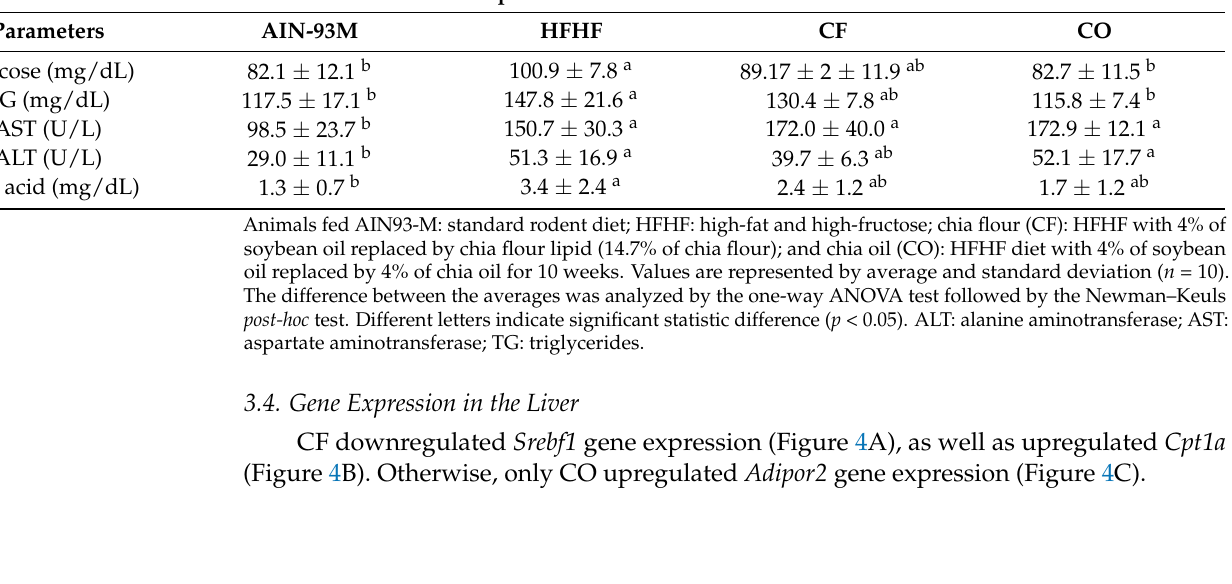
Table 2. Effects of chia on biochemical parameters. Experimental